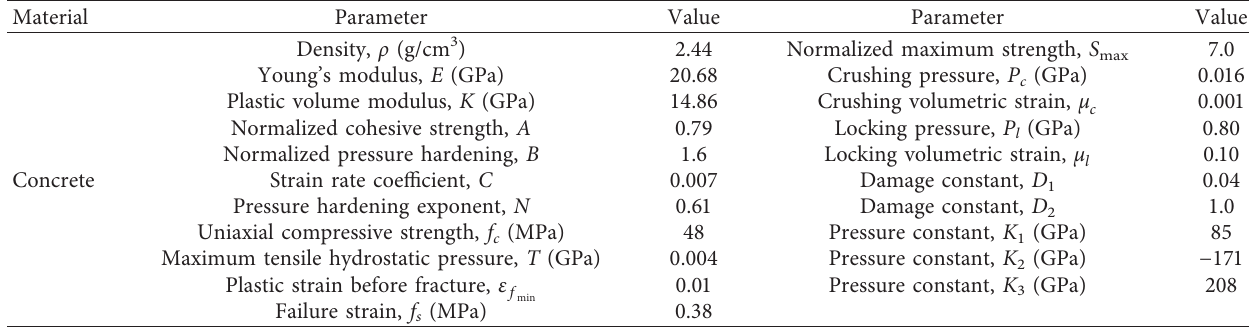
Table 4: Material parameters for concrete target.